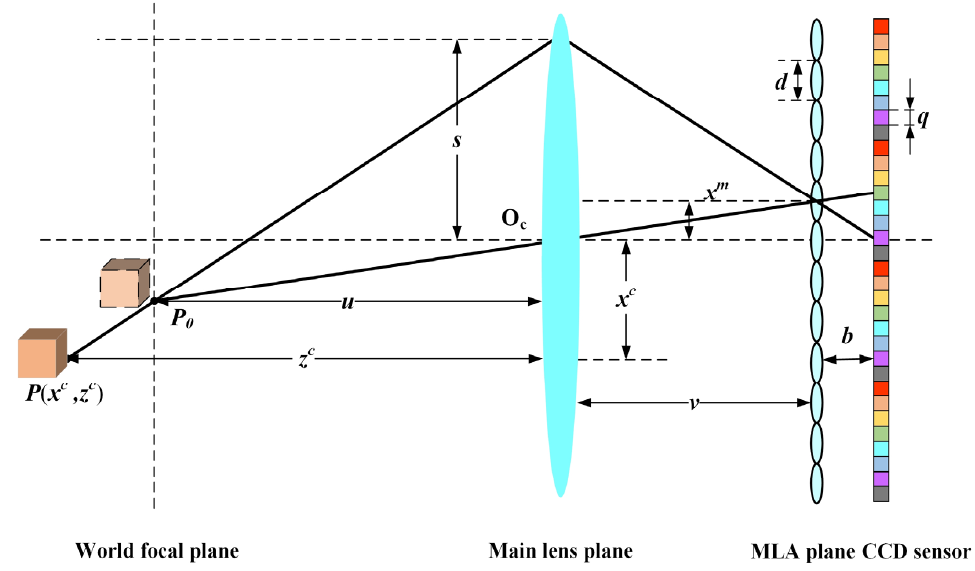
Figure 3. Imaging model of light field camera.